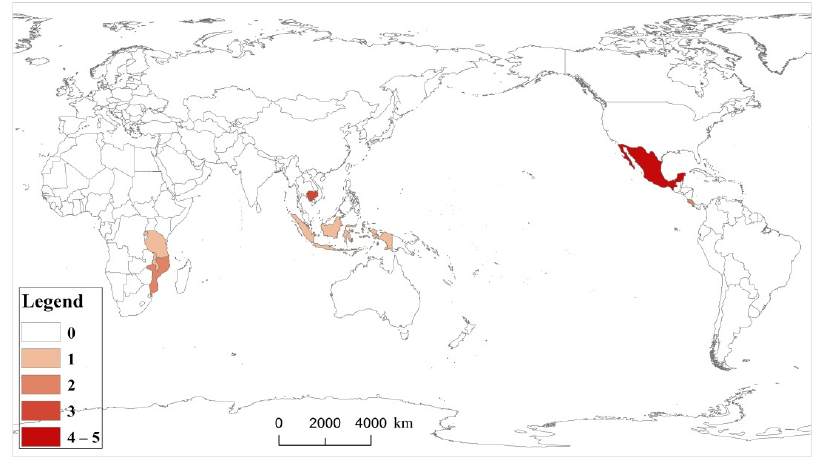
Figure 2. The map of poverty reduction cases of PES in meta-regression analysis.